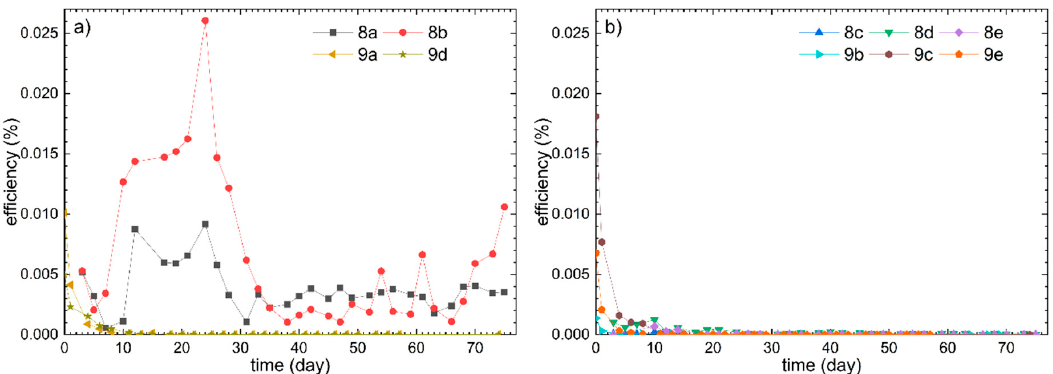
Figure 4. The efficiency progressions of the best DSSCs of samples 8 and 9 are depicted in ( a ) and the other DSSCs of those samples in ( b ). The DSSCs of sample 8 were constructed in the same way as the sample marked as “15%” by Gossen et al . [4], except for slight differences in the recipe for preparing the dye. In sample 9 the commercial liquid Man Solar electrolyte was coated on the front electrode in the same way as it was done with the GPE.